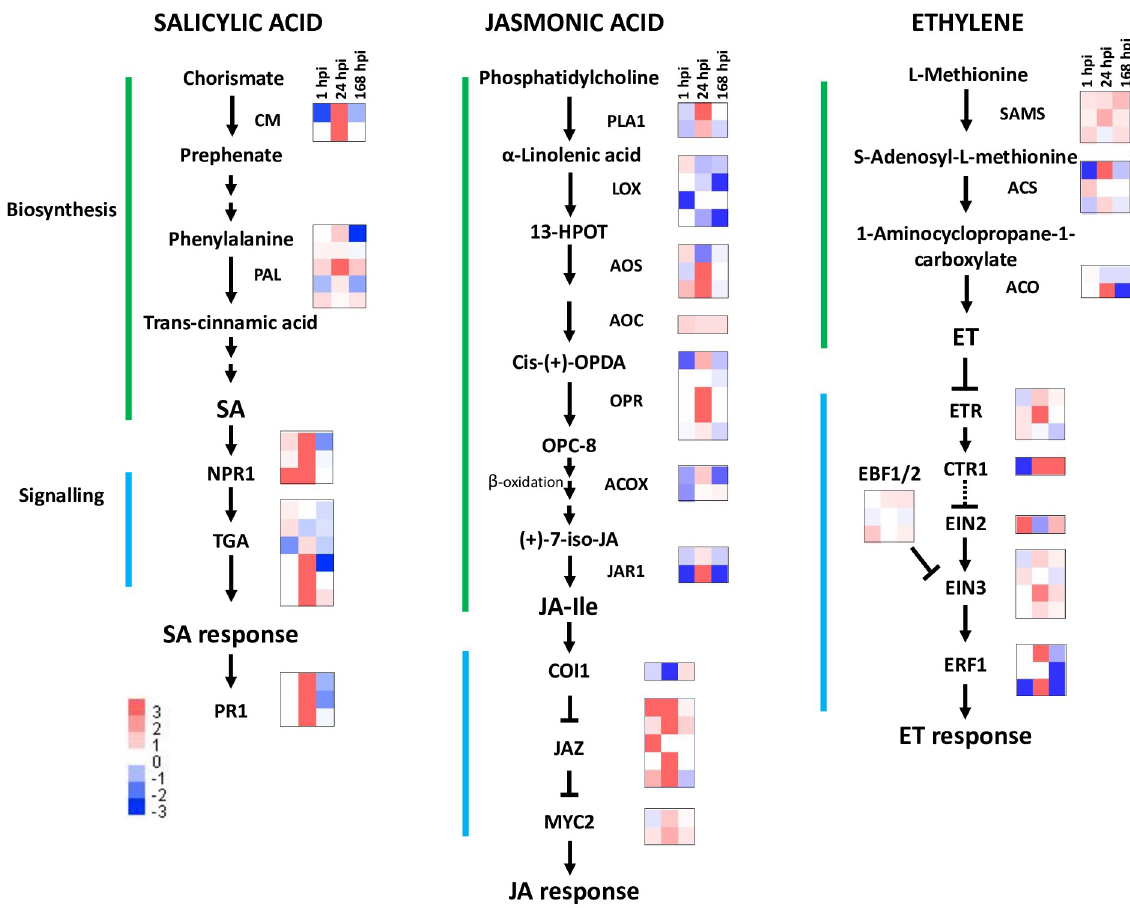
Fig 5. Pathways and heatmaps of RNA-Seq data showing DEGs linked to salicylic acid (SA), jasmonic acid (JA) and ethylene (ET). The SA biosynthesis pathway was adopted from Lefevere et al., 2020 [76], the JA biosynthesis pathway from Wasternack and Hause 2013 [83], and the ET pathway from Dubois et al., 2018 [84]. Hormonal signaling was adopted from the KEGG pathway “sot04075, plant hormone signal transduction” of potato. CM, chorismate mutase; PAL, phenylalanine ammonia-lyase; NPR1, regulatory protein NPR1; TGA, transcription factor TGA; PR1, pathogenesis-related protein 1; PLA1, phospholipase A1; LOX, lipoxygenase; AOS, allene oxide synthase; AOC, allene oxide cyclase; OPR, 12-oxophytodienoic acid reductase; ACOX, acyl-CoA oxidase; JAR1, jasmonic acid-amino synthetase; COI1, coronatine- insensitive protein 1; JAZ, jasmonate ZIM domain-containing protein; MYC2, transcription factor MYC2; SAMS, S-adenosylmethionine synthase; ACS, 1-aminocyclopropane-1-carboxylate synthase; ACO, aminocyclopropanecarboxylate oxidase; ETR, ethylene receptor; CTR1, serine/threonine-protein kinase CTR1; EIN2, ethylene-insensitive protein 2; EIN3, ethylene-insensitive protein 3; EIL, Ethylene insensitive 3-like; EBF, EIN3-binding F-box protein; ERF, ethylene-responsive transcription factor. The expression levels of individual genes are shown in S2